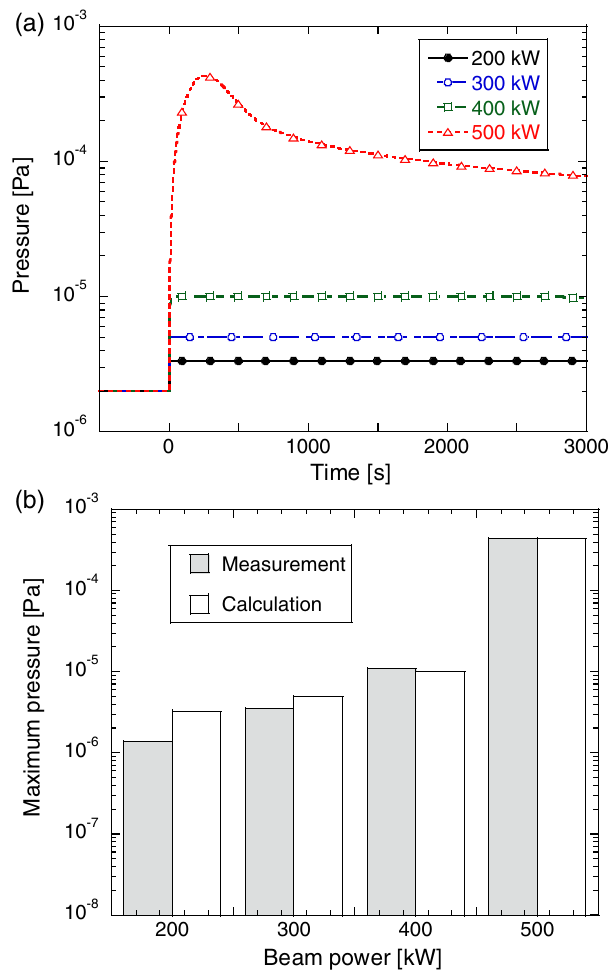
FIG. 20. Dependence of the pressure on the beam power at point G in Fig. 14 [Fig. 17(b)]. In the calculation, the q 0 value is fixed to 4 × 10 20 m − 2 , which is the value obtained for the case of 500 kW beam power [Fig. 19(a)]. (a) Calculated time variation of the pressure. The origin of the horizontal axis is set to the time when the beam operation started. (b) Comparison of the calcu- lated maximum pressure with the one measured by the CCG in C15 at each beam power.